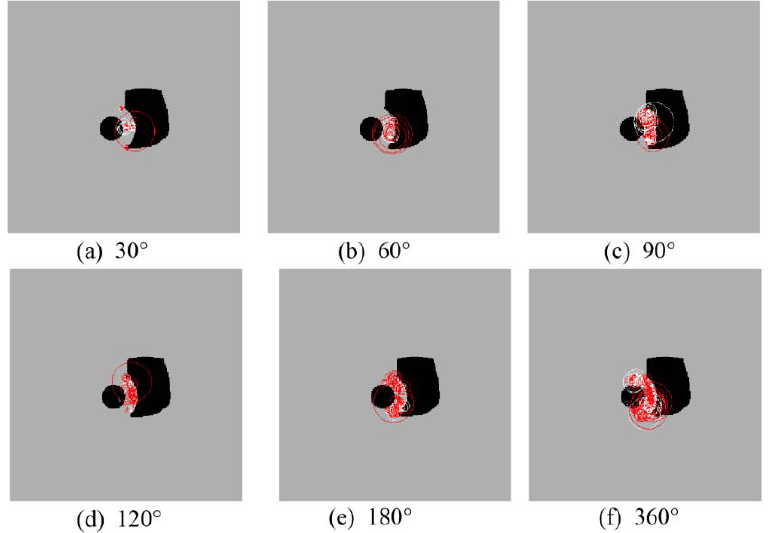
Figure 10. Acoustic emission diagram of grout damage for different grouting ranges: ( a ) grouting range of 30°; ( b ) grouting range of 60°; ( c ) grouting range of 90°; ( d ) grouting range of 120°; ( e ) grouting range of 180°; ( f ) grouting range of 360°.